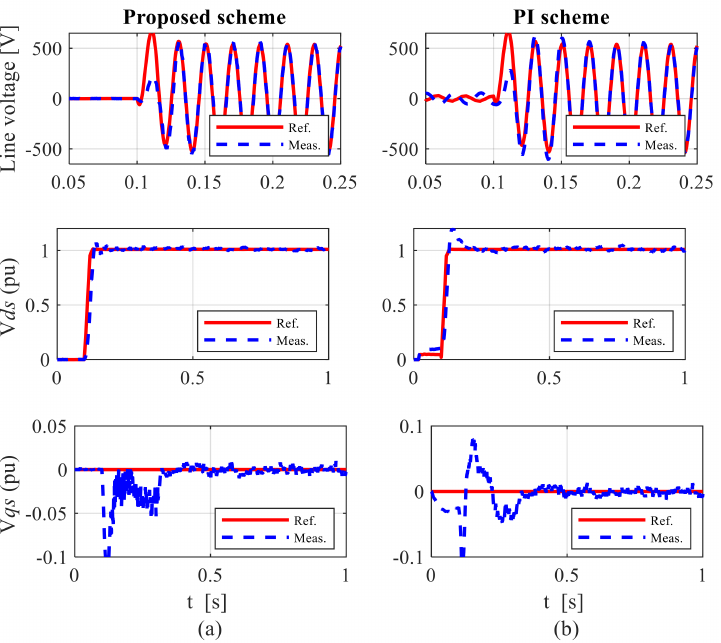
Figure 8. Control performances during sub-synchronous speed operation under external disturbance: ( a ) proposed scheme and ( b ) PI